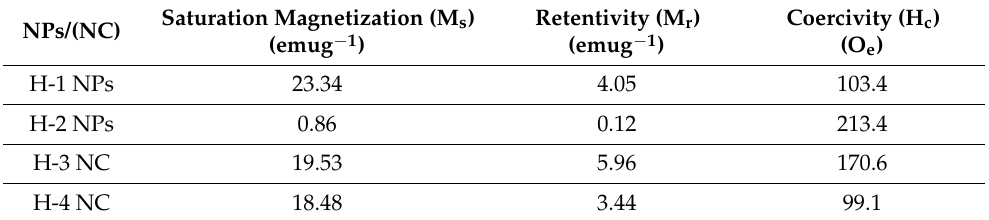
Figure 3. Magnetic Hysteresis loop of H-1 NPs; H-2 NPs; H-3 NPs; H-4 NPs. Table 2. Saturation Magnetization, Coercivity, Retentivity of H-1, H-2, H-3 and H-4